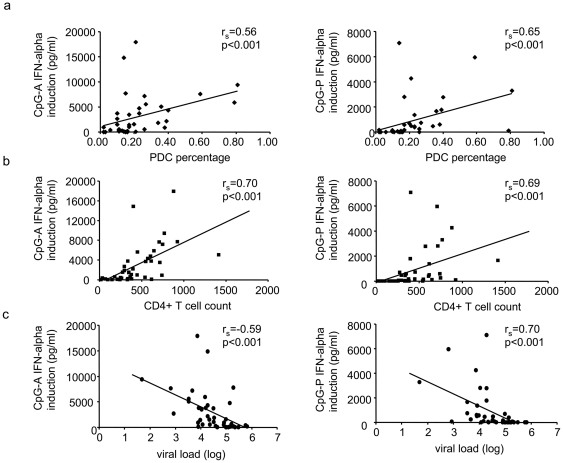
Correlation of CpG-induced interferon (IFN)-alpha production with clinical parameters.Spearman rank order correlation of CpG-A and CpG-P induced IFN-alpha production with (a) the percentage of PDC, (b) the CD4+ T cell count, and (c) the viral load in untreated HIV-1 infected individuals (n = 40).